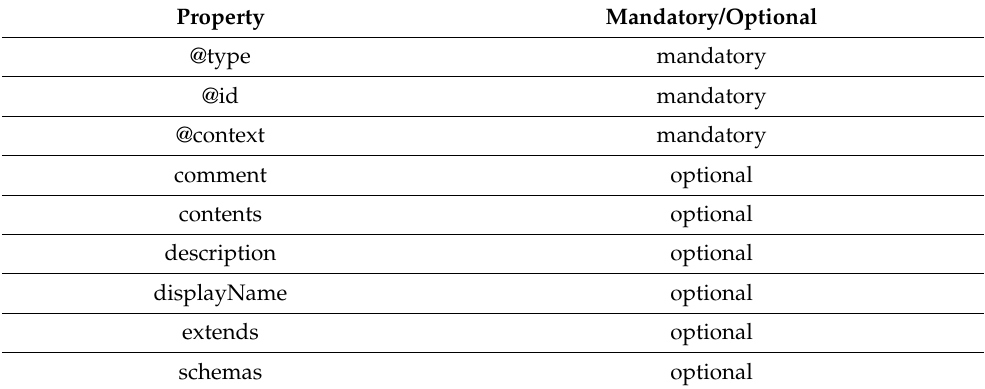
Table 3. Properties of Interface